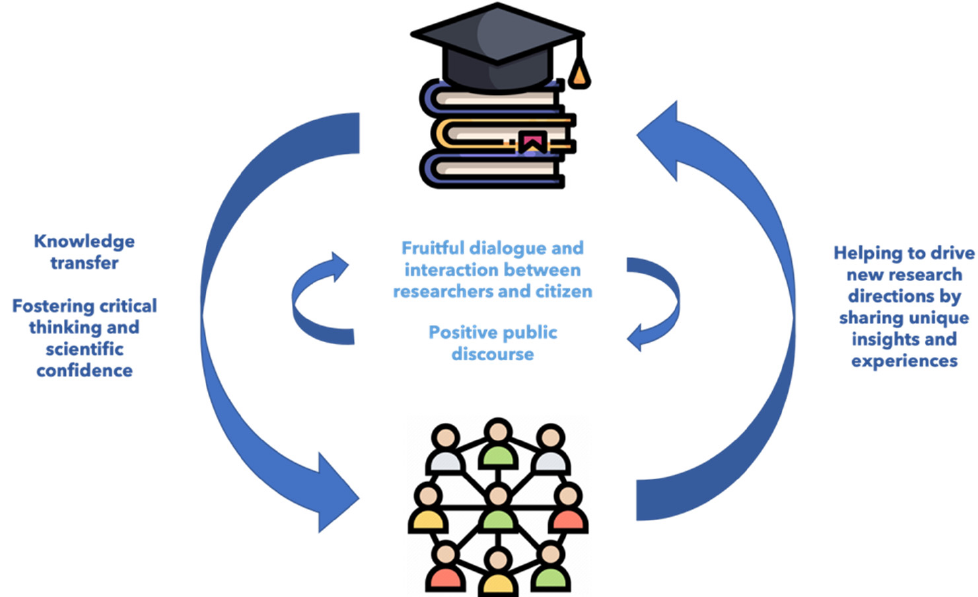
Figure 1. Public engagement as part of third mission activities.